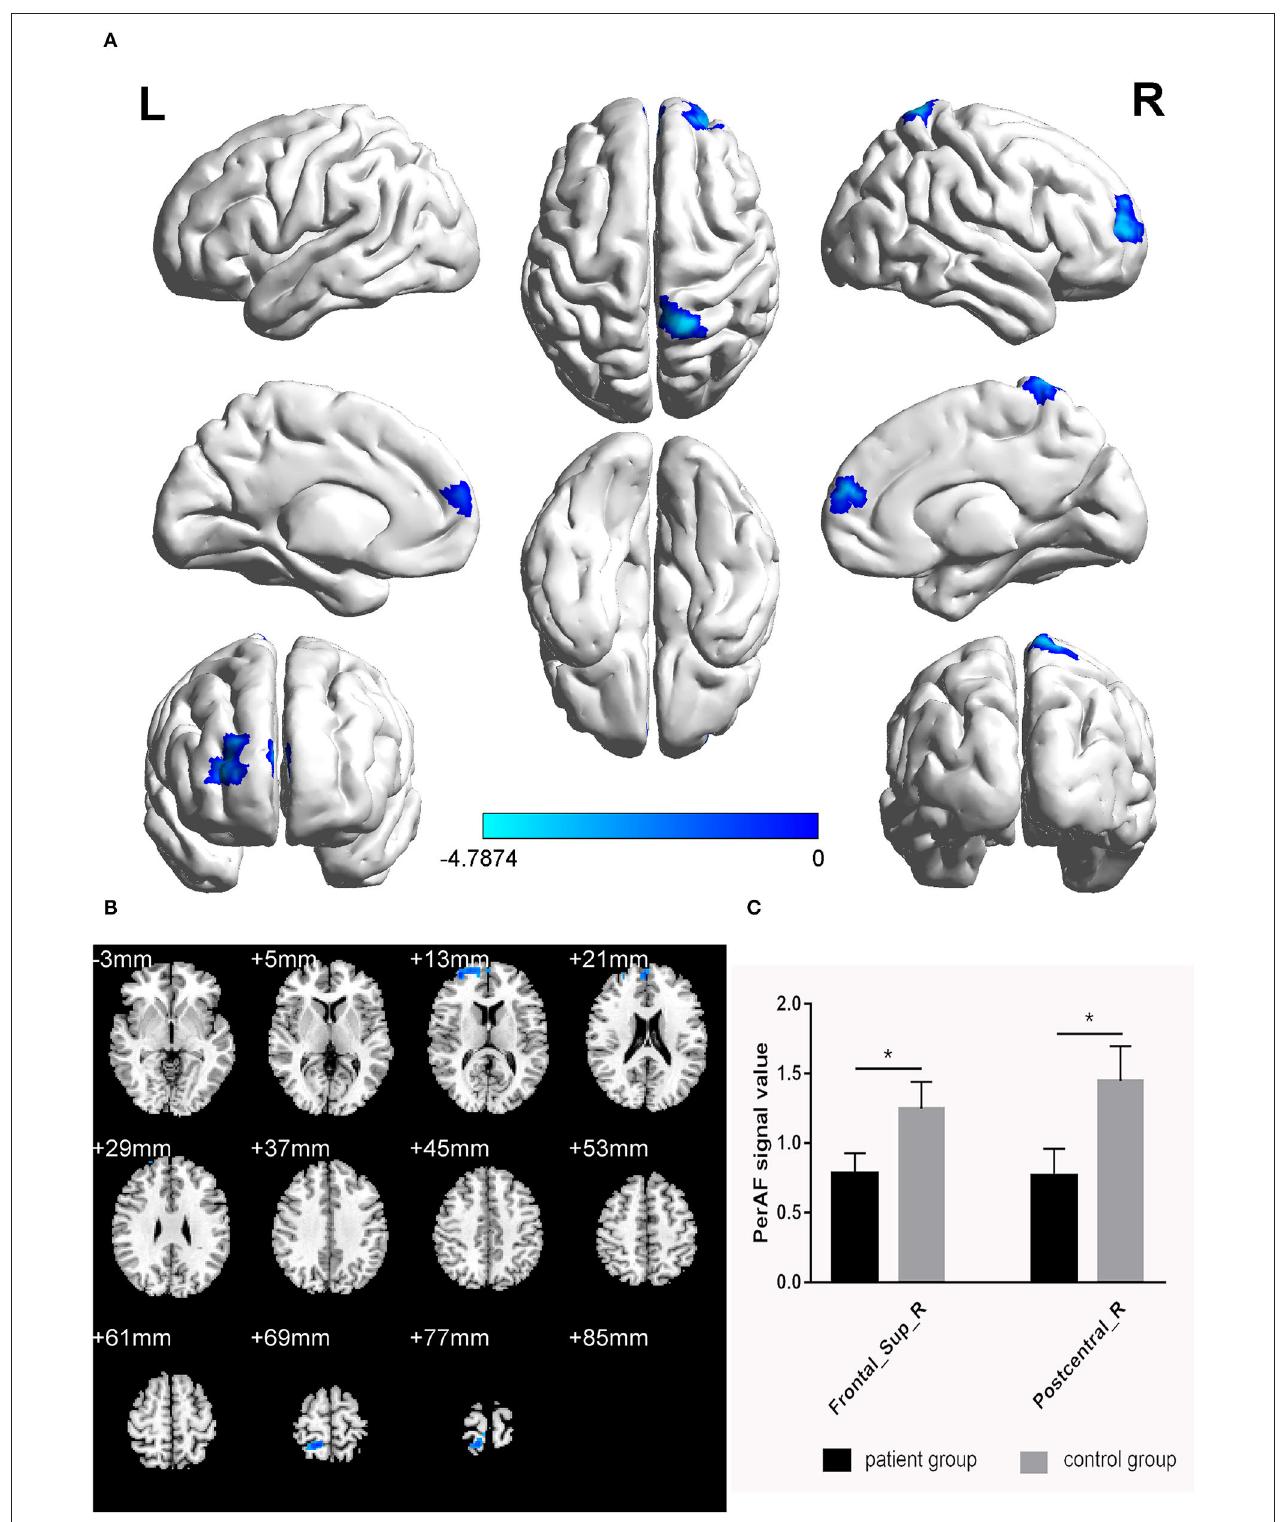
FIGURE 1 | Significant differences in brain activity (A,B) . Blue areas indicate lower PerAF values. AlphaSim performed multiple comparisons at cluster sizes > 40 voxels and P < 0.05, obtained by Gaussian random field theory. (C) ALFF mean values between TA group and HC. PerAF, percent amplitude of fluctuation; Frontal_Sup_R, right dorsolateral superior frontal gyrus; Postcentral_R, right posterior central gyrus. *represents significant difference.